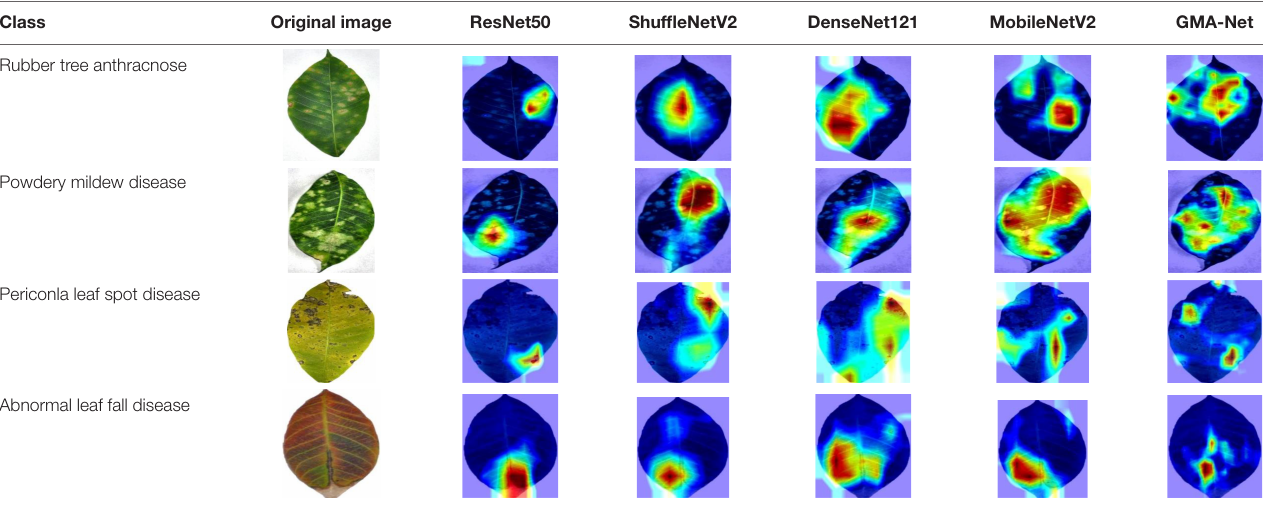
TABLE 7 | Visualization results of different